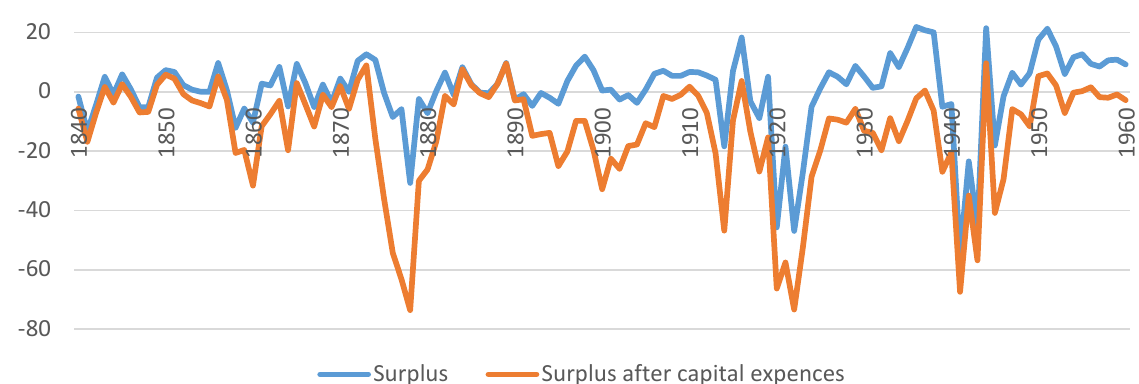
Figure 7. Fiscal balance, central government, percent of income,